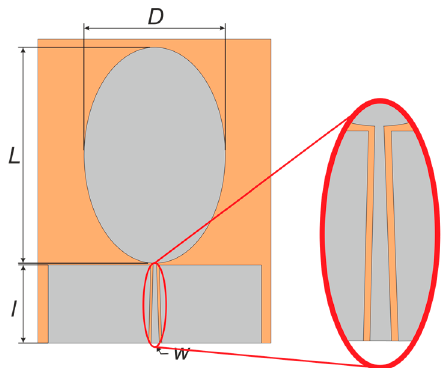
Figure 1. The proposed antenna with the critical point highlighted from the technological point of